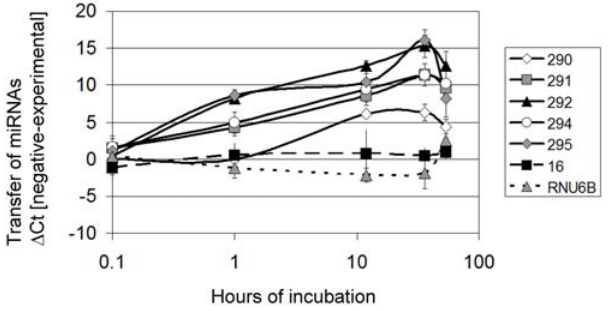
Figure 7. ESMVs transfer miRNAs. MEFs were incubated with ESMVs for 1, 12, 36, or 54 hours and transfer of miRNAs was determined by real time quantitative RT-PCR (n=5). Time point 0 represents MEFs without ESMVs. The difference in Ct values between the negative control (MEFs alone) and each experimental group (miR-290, miR-291- 3p, miR-292-3p, miR-294, miR-295, miR-16, and RNU6b) is shown. Positive values indicate transfer of miRNA.